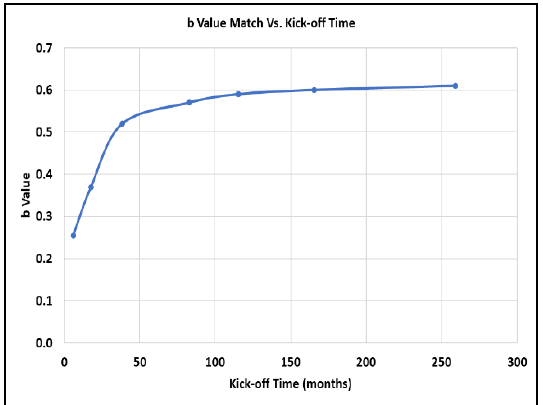
Figure A6. (left). Correlation of b-value match for secondary hyperbolic decline with corresponding kick-off times due to differing well spacing.